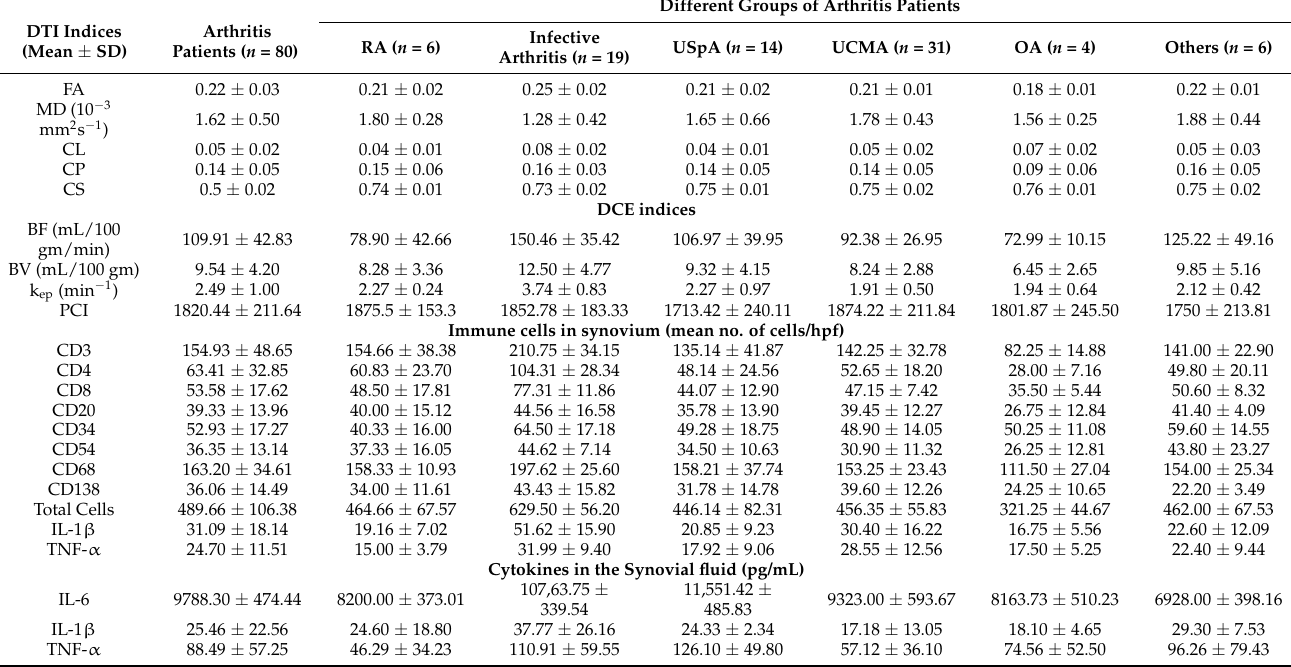
Table 3. Descriptive values of imaging and immunohistochemical parameters in different groups of arthritis patients.